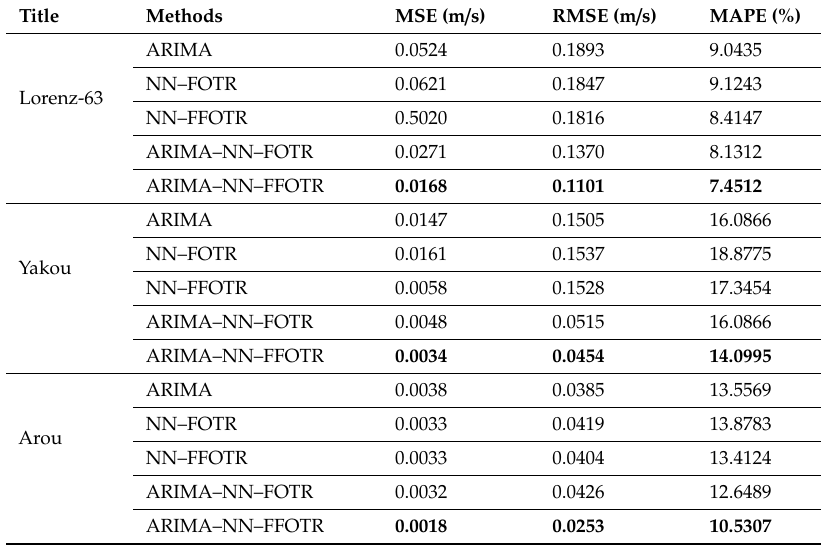
Figure 11. Results of the predictions for the wind speed at the Arou site. ( a ) Overall, ( b ) local enlargement, ( c ) RMSEs for the wind speed at the Arou site. Table 5. Forecasting results of time-series under di ff erent